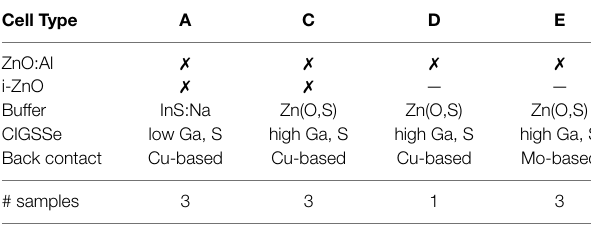
TABLE 1 | Overview of the cell types used in this